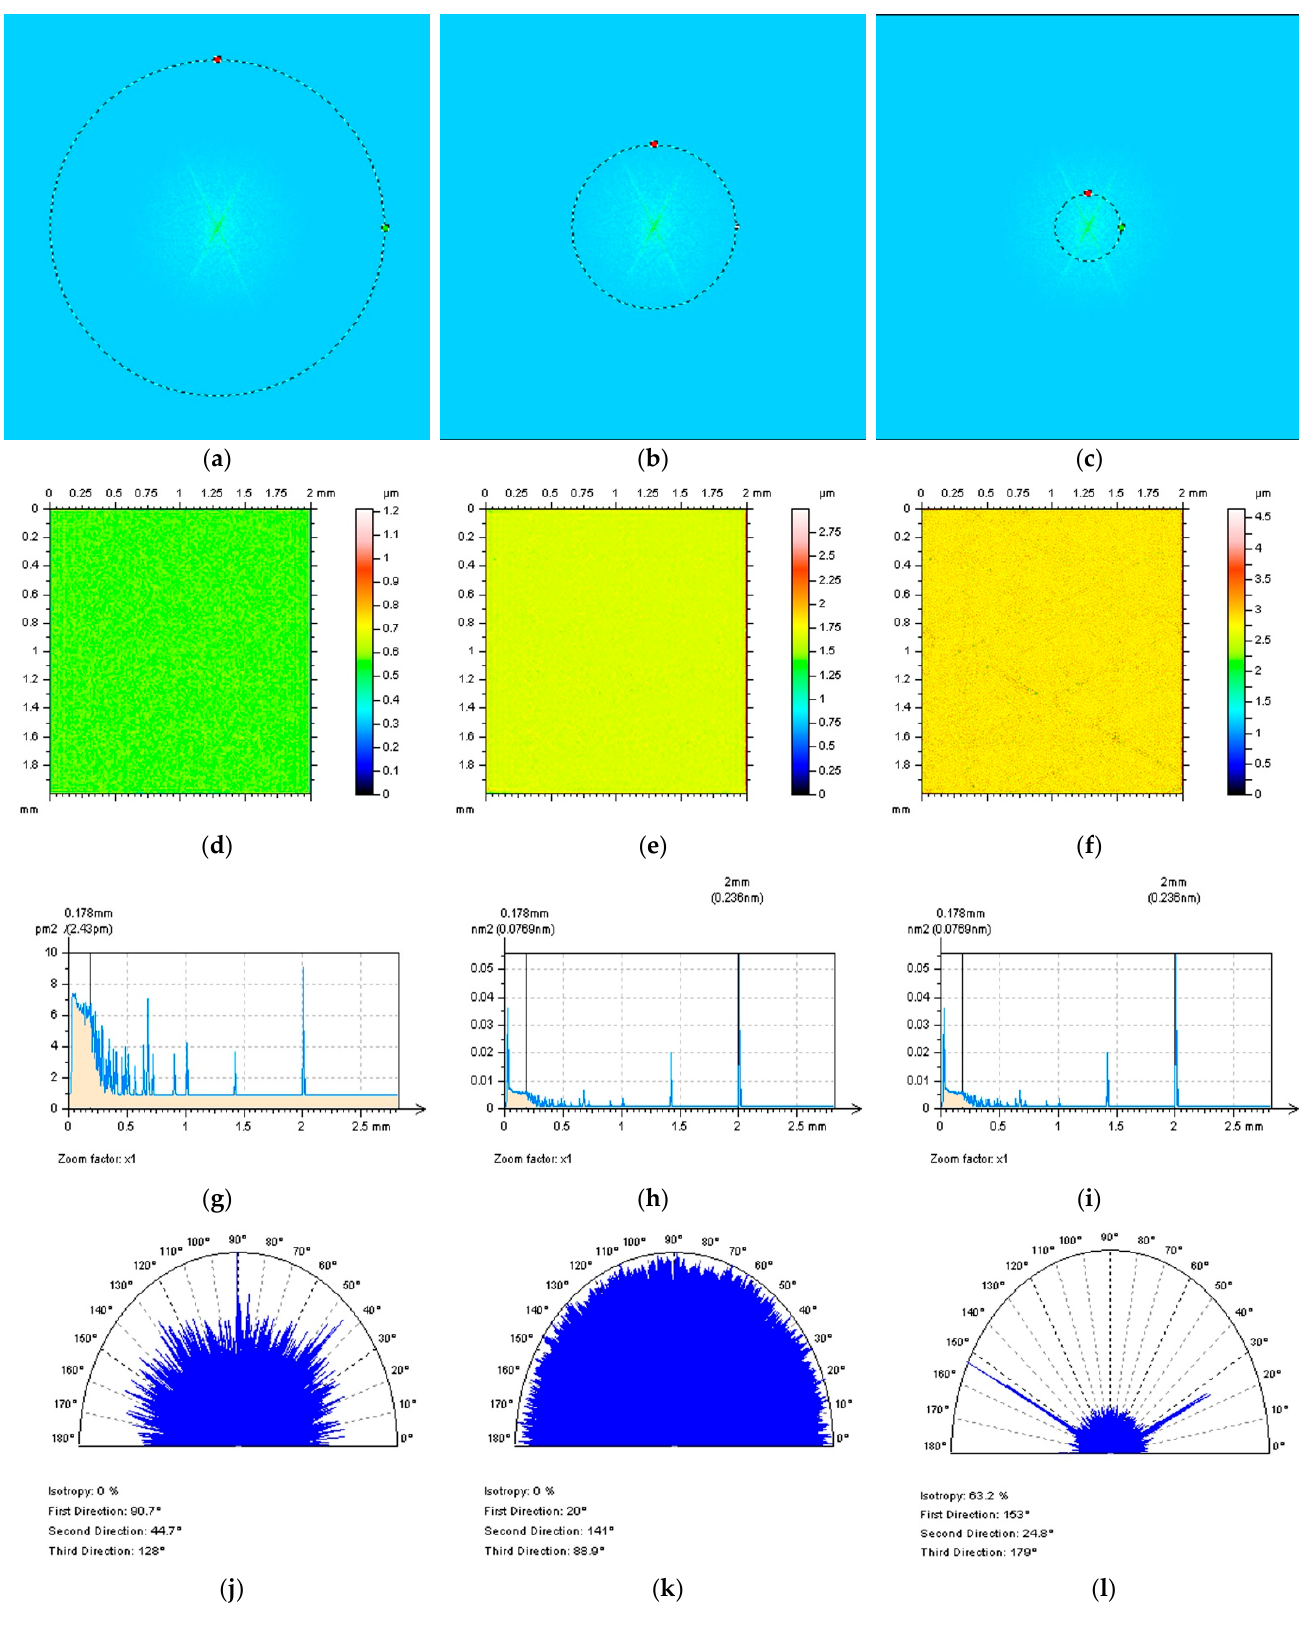
Figure 4. Contour map plots ( a – c ) of HFNS received from ground surface after application of GF (left column), SF (middle) and MDF (right column), their PSDs ( d – f ), ACFs ( g – i ), extraction of ACFs based on direction of the treatment traces ( j – l ) and TD graphs ( m – o ), respectively, cut–off = 0.025 mm.